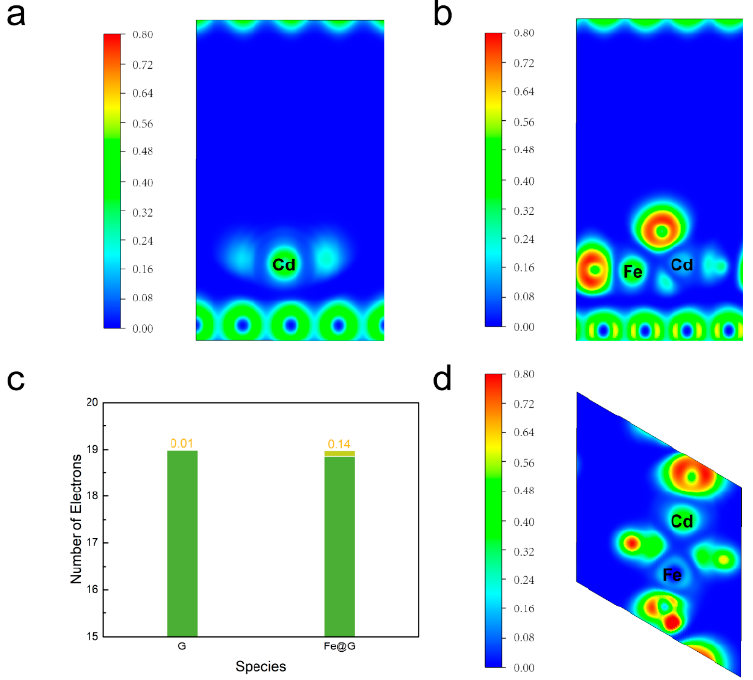
Figure 4. ELF diagram of CdCl 2 on G ( a ) and Fe@G ( b ). ( c ) The number of charge transfers of the Cd site for the CdCl 2 on substrates. Note that the dark and light green regions correspond to the number of electrons of the Cd for the CdCl 2 after adsorption on substrates, and the difference value with the electrons of the Cd for the pure CdCl 2 , respectively. ELF diagram of top view of CdCl 2 on Fe@G ( d ).